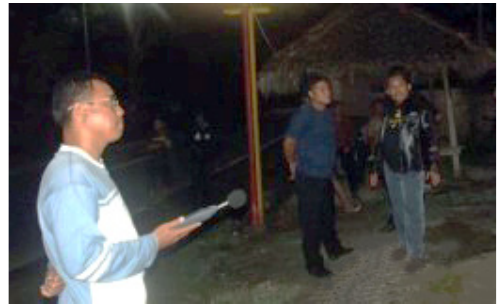
Figure 4. An example of improper noise measurement using sound level meter taken by Badan Lingkungan Hidup (BLH) Lombok Barat in Lombok Island Indonesia in dealing with community complaints regarding noise from a karaoke café (Subardi, 2015)